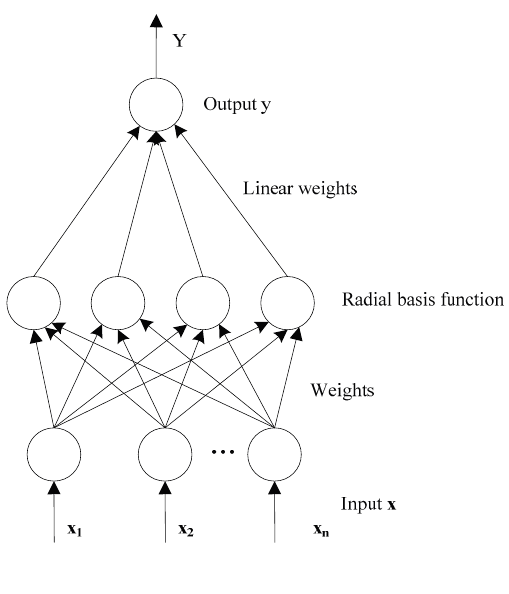
Figure 2. The structure of the RBF